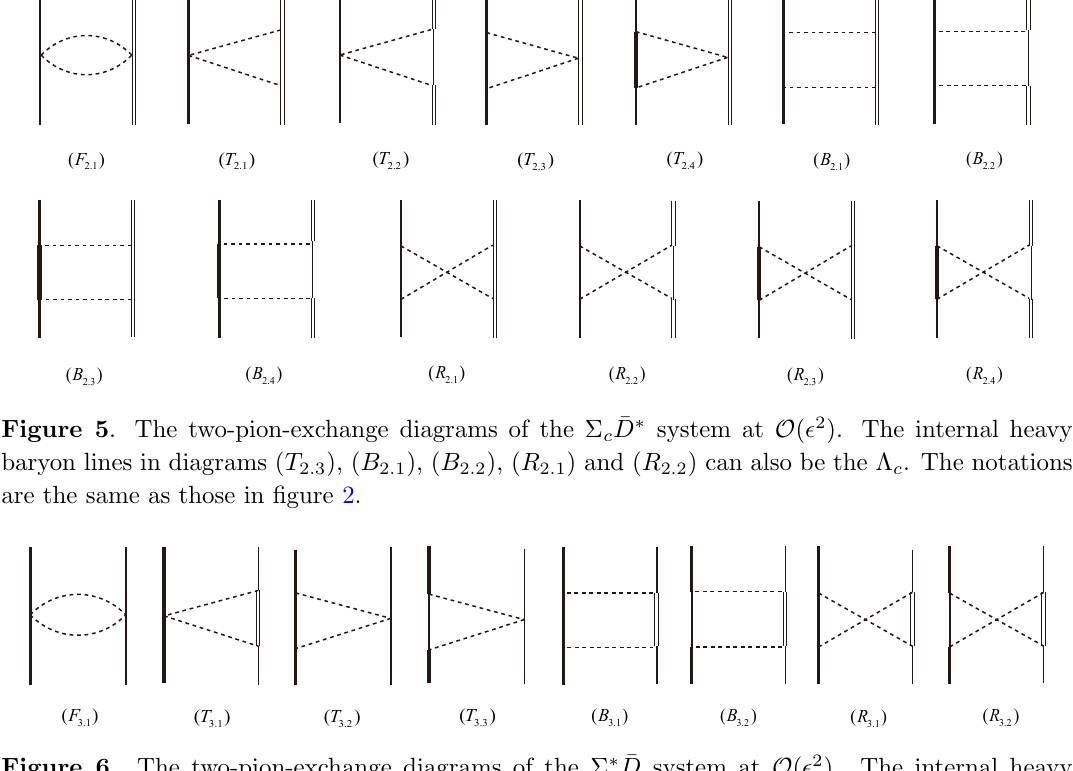
Figure 6 . The two-pion-exchange diagrams of the (cid:6) (cid:3) baryon lines in diagrams ( T 3 : 3 ), ( B 3 : 2 ) and ( R 3 : 2 ) can also be the (cid:3) c . The notations are the same as those in (cid:12)gure